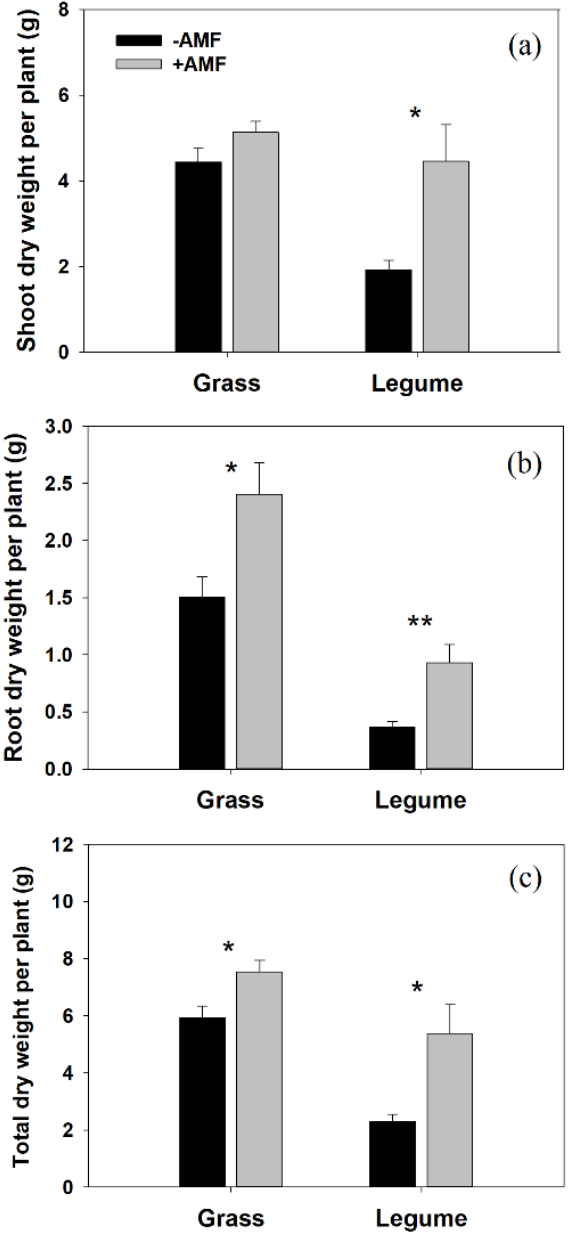
Figure 1. Shoot dry weight (DW), root DW, and total DW of host plants ( a – c ). Data are presented as the mean ± standard error. There are seven replicates for the nonmycorrizal grass-hemiparasite association, five replicates for the nonmycorrizal legume-hemiparasite association, and four replicates for the mycorrizal grass-hemiparasite and legume-hemiparasite associations. Grass: Elymus nutans ; Legume: Trifolium repens . Significant differences (as determined by t test) between mycorrhizal (gray bars) and non-mycorrhizal (black bars) treatments are indicated by asterisks (* p < 0.05, ** p < 0.01). Biomass data of E. nutans were taken from Sui et al. [30].